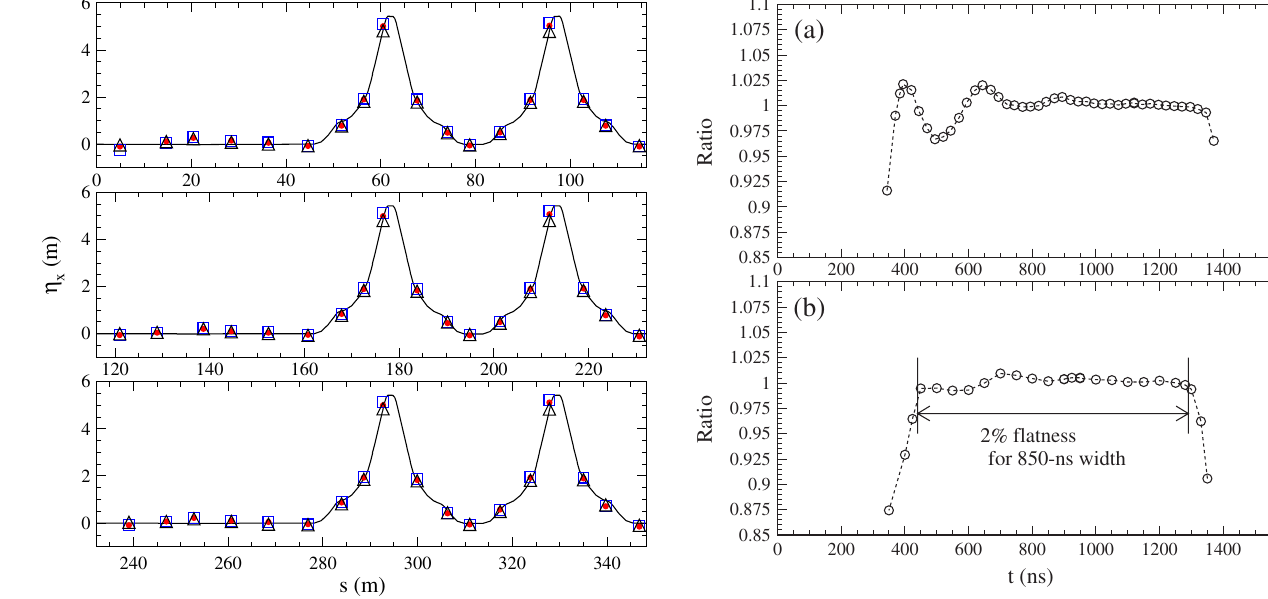
FIG. 24. (Color) Horizontal dispersions measured at 12 (closed red circles), 15 (open blue squares), and 18 (open black tri- angles) ms for the acceleration period (20 ms). Solid curves are the